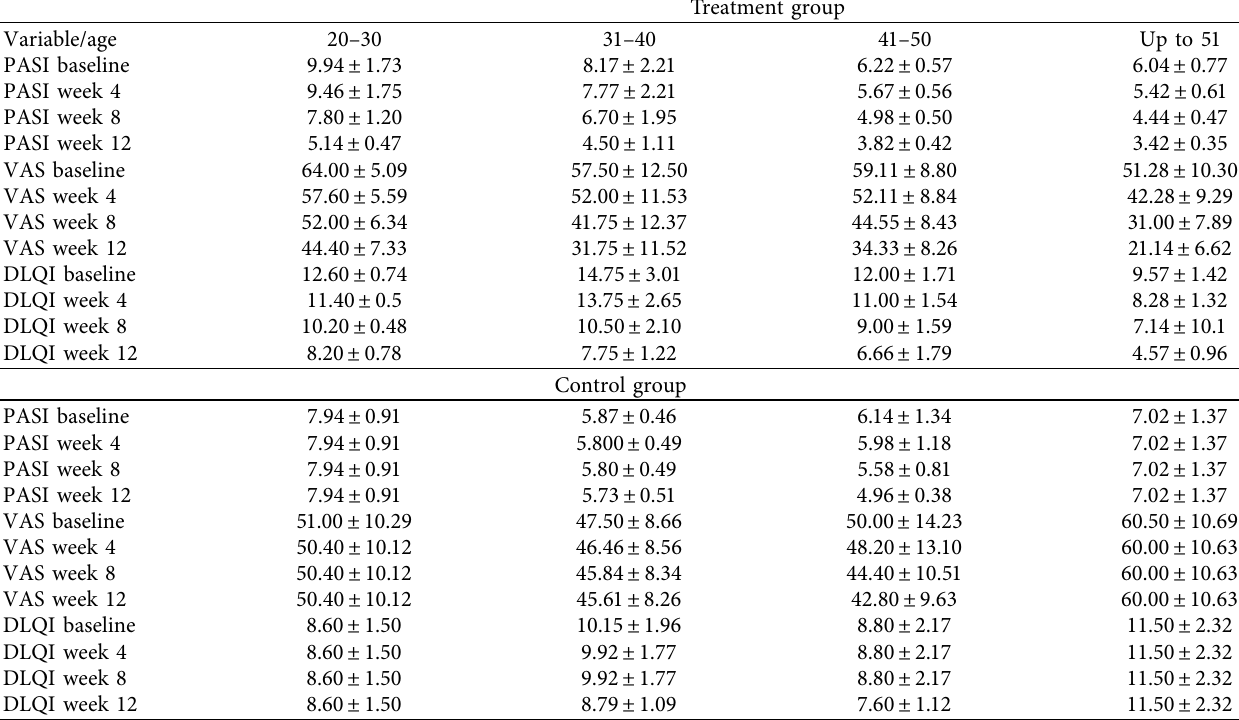
Table 5: The PASI, VAS, and DLQI scores of various